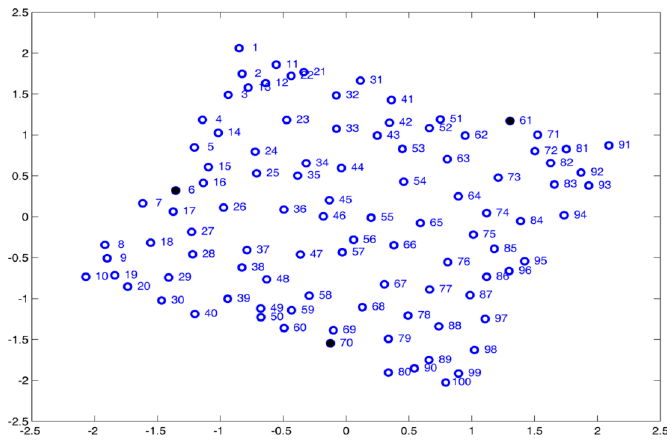
Figure 6. Relative map obtained with MDS-MAP(C) algorithm. 𝑅 = 1.5𝑟 .